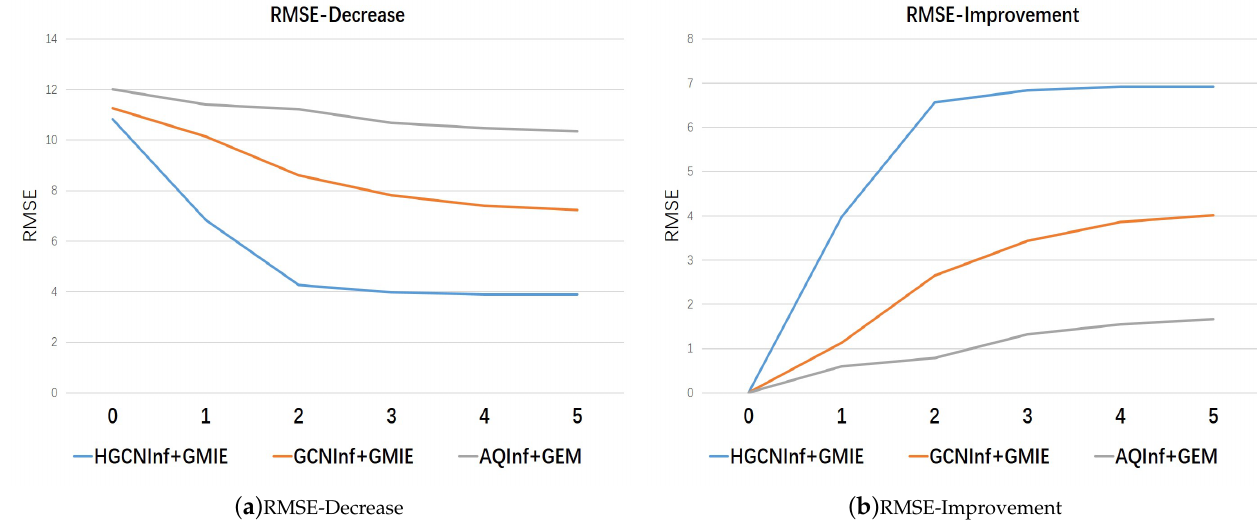
Figure 14. The RMSE results when gradually increase the number of recommended stations according to its